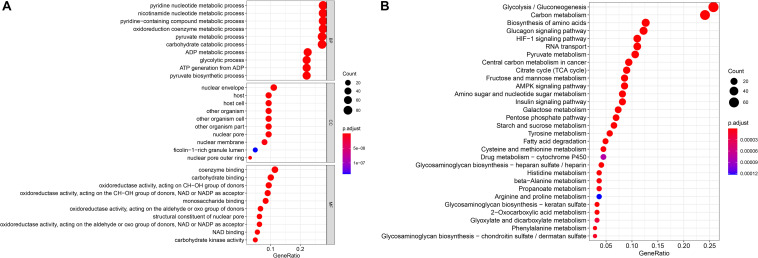
Gene functional enrichment of the 289 specific glycometabolism-related genes. (A) Gene Ontology analysis; BP,CC and MF represent biological process, cellular component and molecular function, respectively. (B) The most significant Kyoto Encyclopedia of Genes and Genomes (KEGG) pathways.